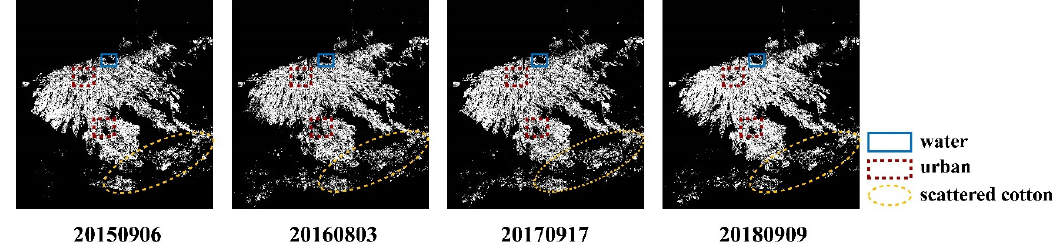
Figure 8. The spatial variations of cotton field cultivated area from 2015–2018 in Wei-Ku Oasis based on DenseNet.